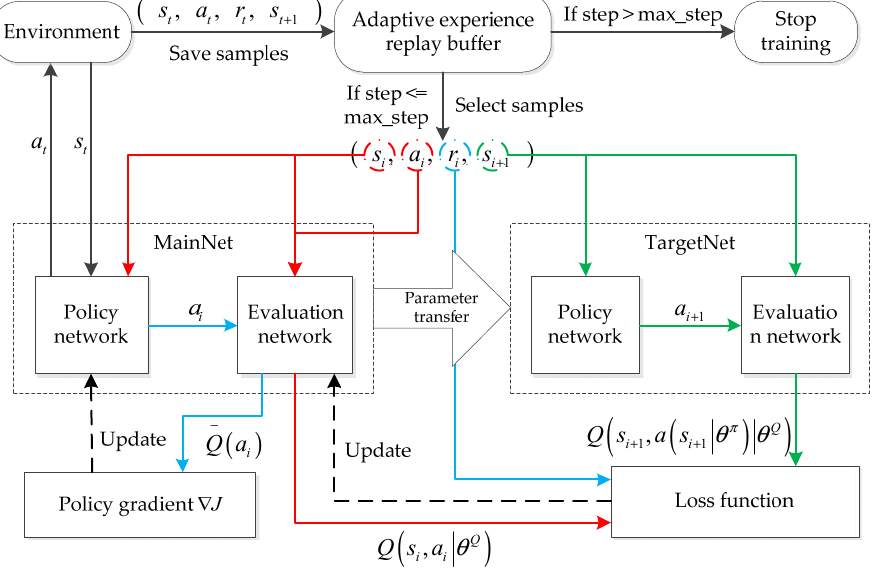
Figure 3 . The flowchart of the proposed algorithm. Figure 3. The flowchart of the proposed